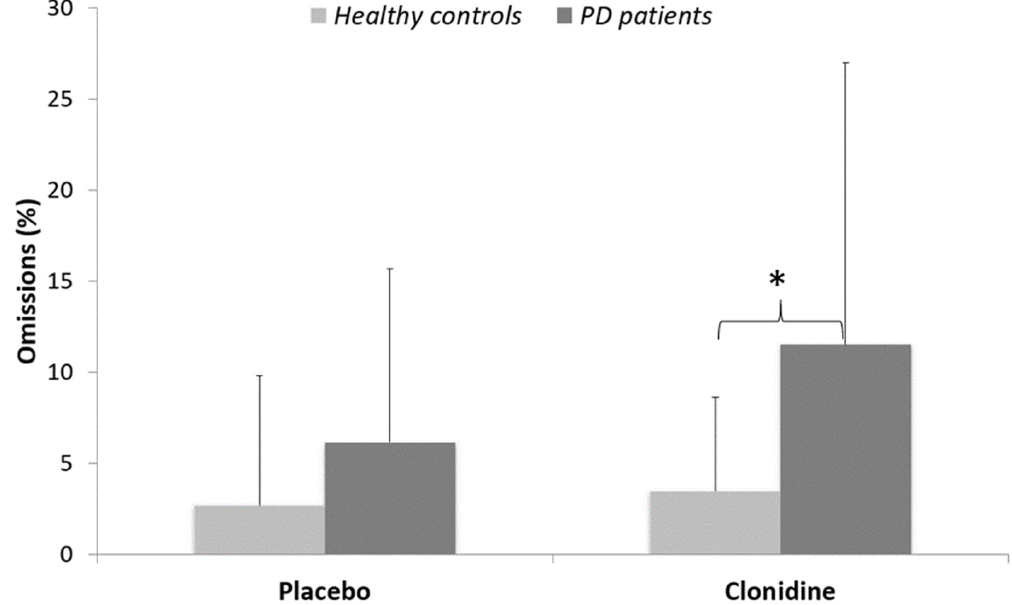
Figure 4. Percentages of omissions (means and standard deviations) for PD patients versus healthy matched controls. * p <0.05.